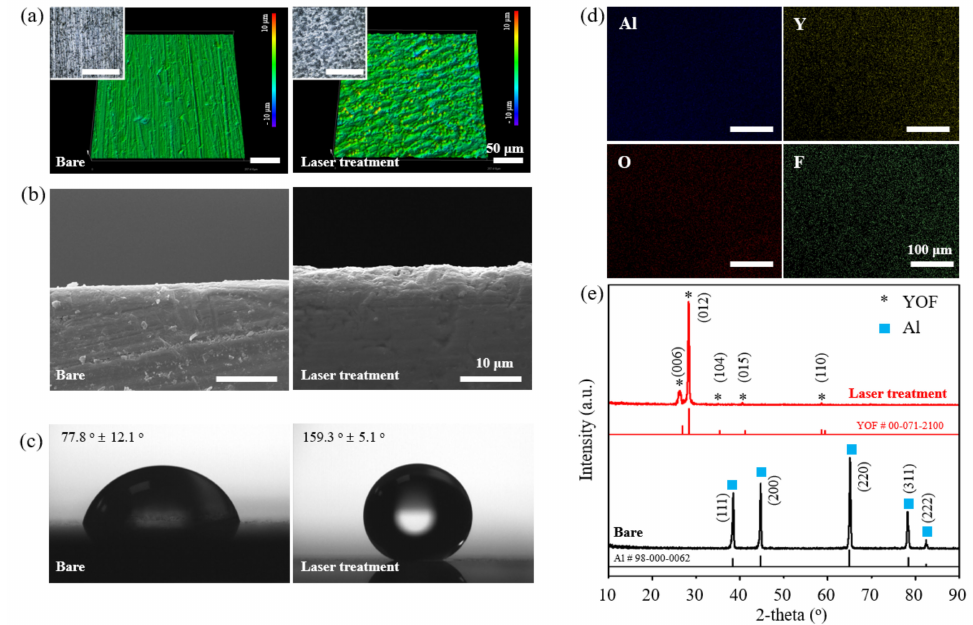
Figure 6. Analysis of surface properties after YOF coating via laser treatment: ( a ) Optical (inset) and surface morphology images before and after coating. ( b ) SEM images of the cross-section and ( c ) contact angle of the surface before and after coating. ( d ) Mapping images of Y, O, and F distribution by EDS. ( e ) Phase identification by XRD measurement before and after coating.